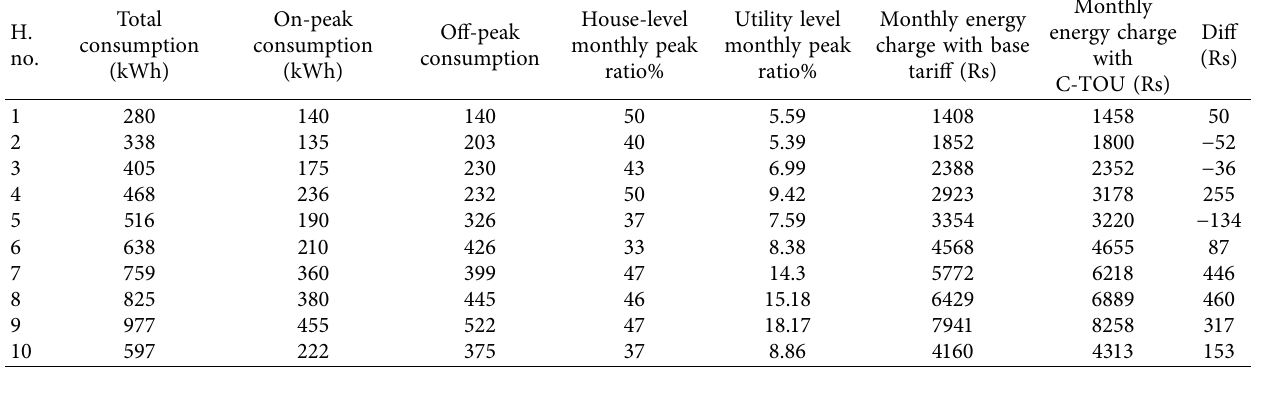
Table 4: Monthly energy charge of 10 customers with and without C-TOU for a nonsummer month. H.